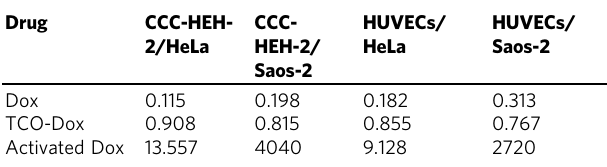
Table 2 Calculated EC 50 ratios of Dox, TCO-Dox and activated Dox against each cell